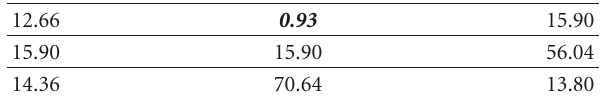
Table 2: Matrix M 2 .